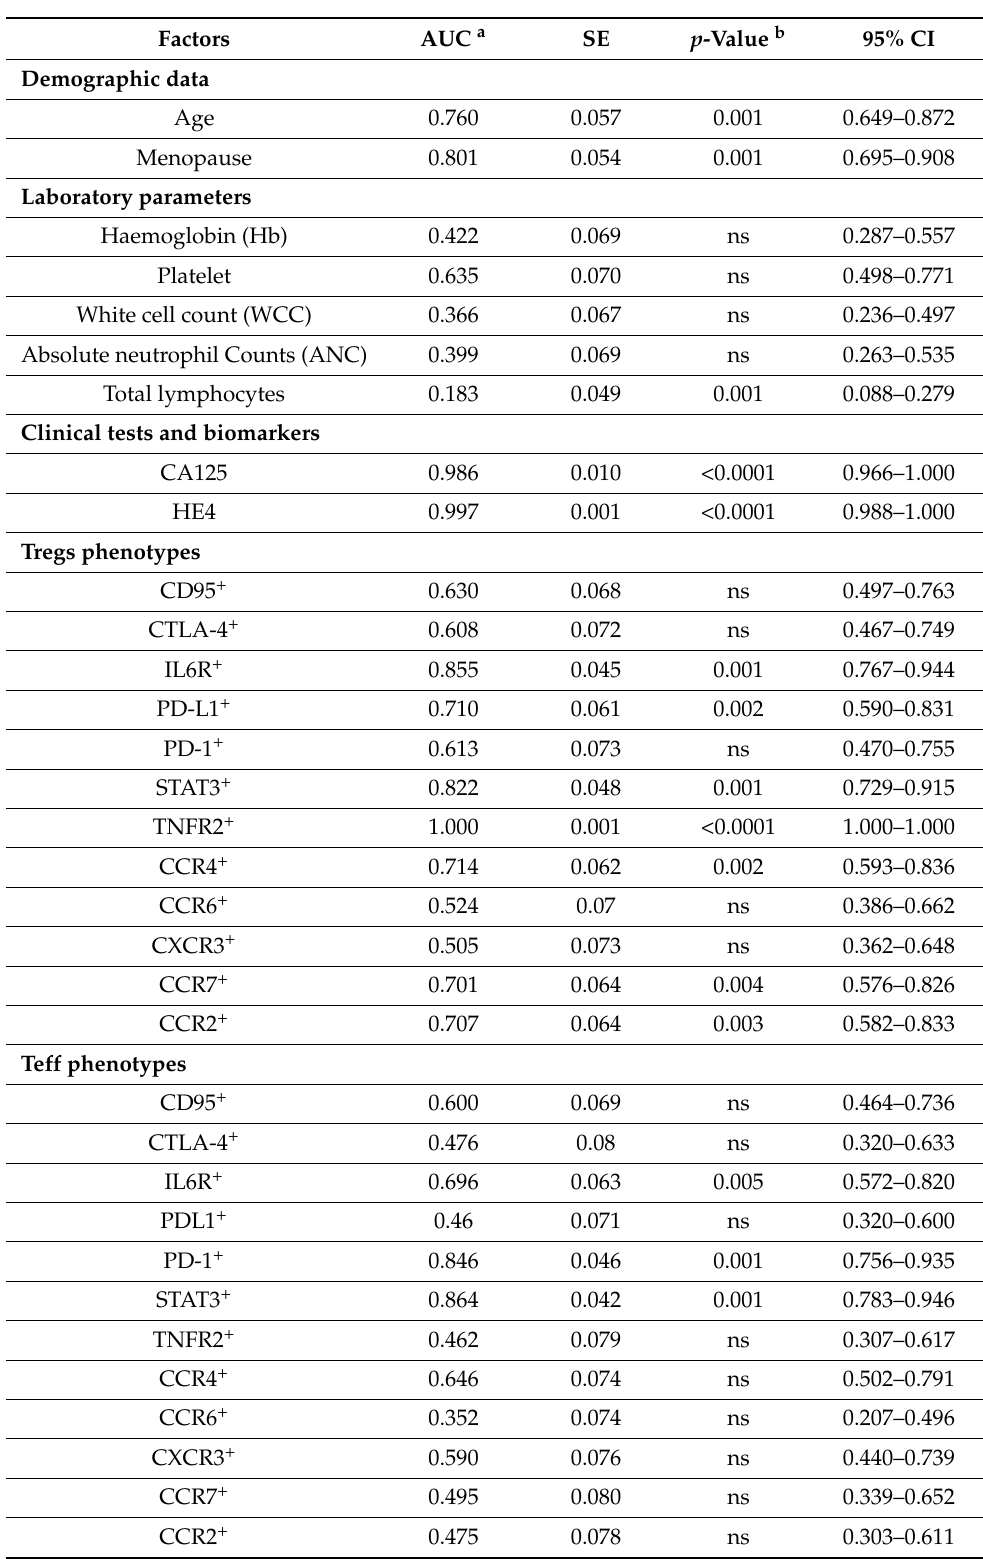
Table 3. Comparison of ROC-AUC values of demographic and pre-treatment immune factors for patients with malignant and non-malignant ovarian